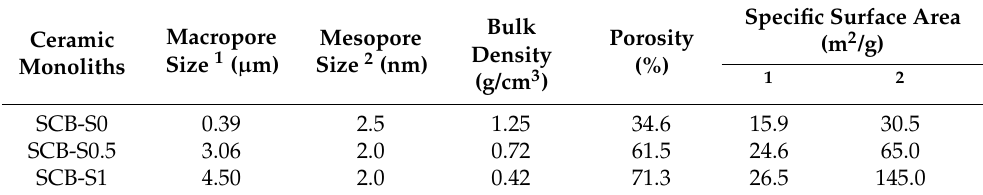
Figure 6. XRD patterns of the hybrid gels after being heated at 1100 °C – 1400 °C in vacuum. The holding time at targeted temperature is 1 h. Table 1. Pore size, bulk density, porosity and specific surface area of the hierarchical porous SiC